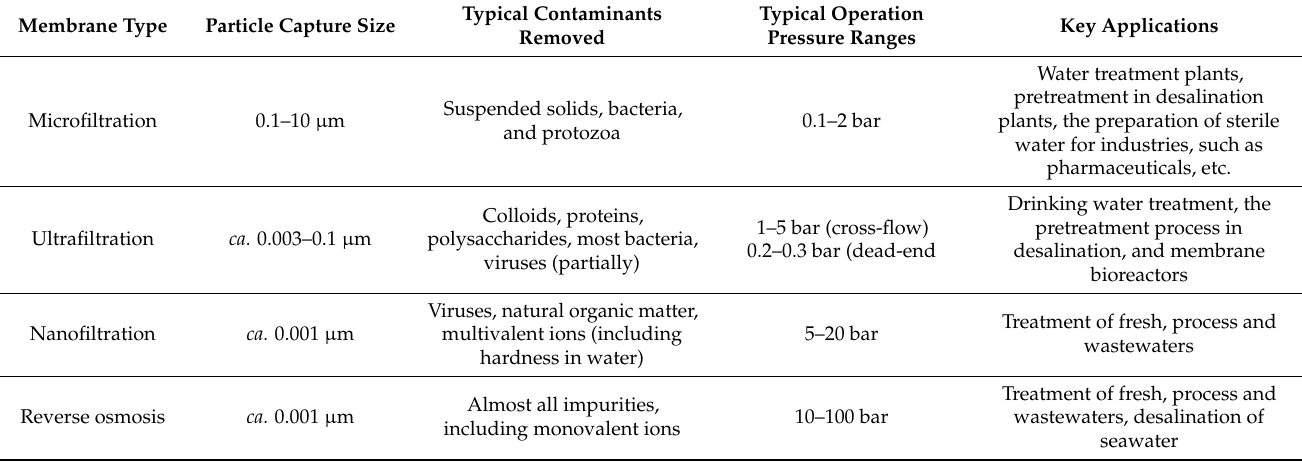
Figure 9. Desalination and water purification technologies by Department of Atomic Energy (as of June 2010). Table 3. Specific characteristics of membrane techniques for water treatment and desalination (adapted from